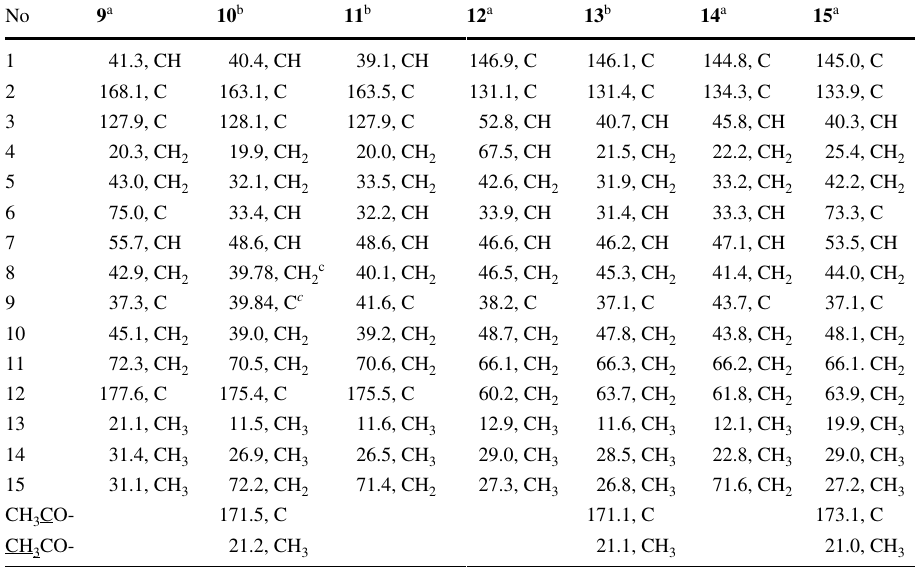
Table 5 13 C NMR spectroscopic data of compounds 9 – 15 (150 MHz, δ in